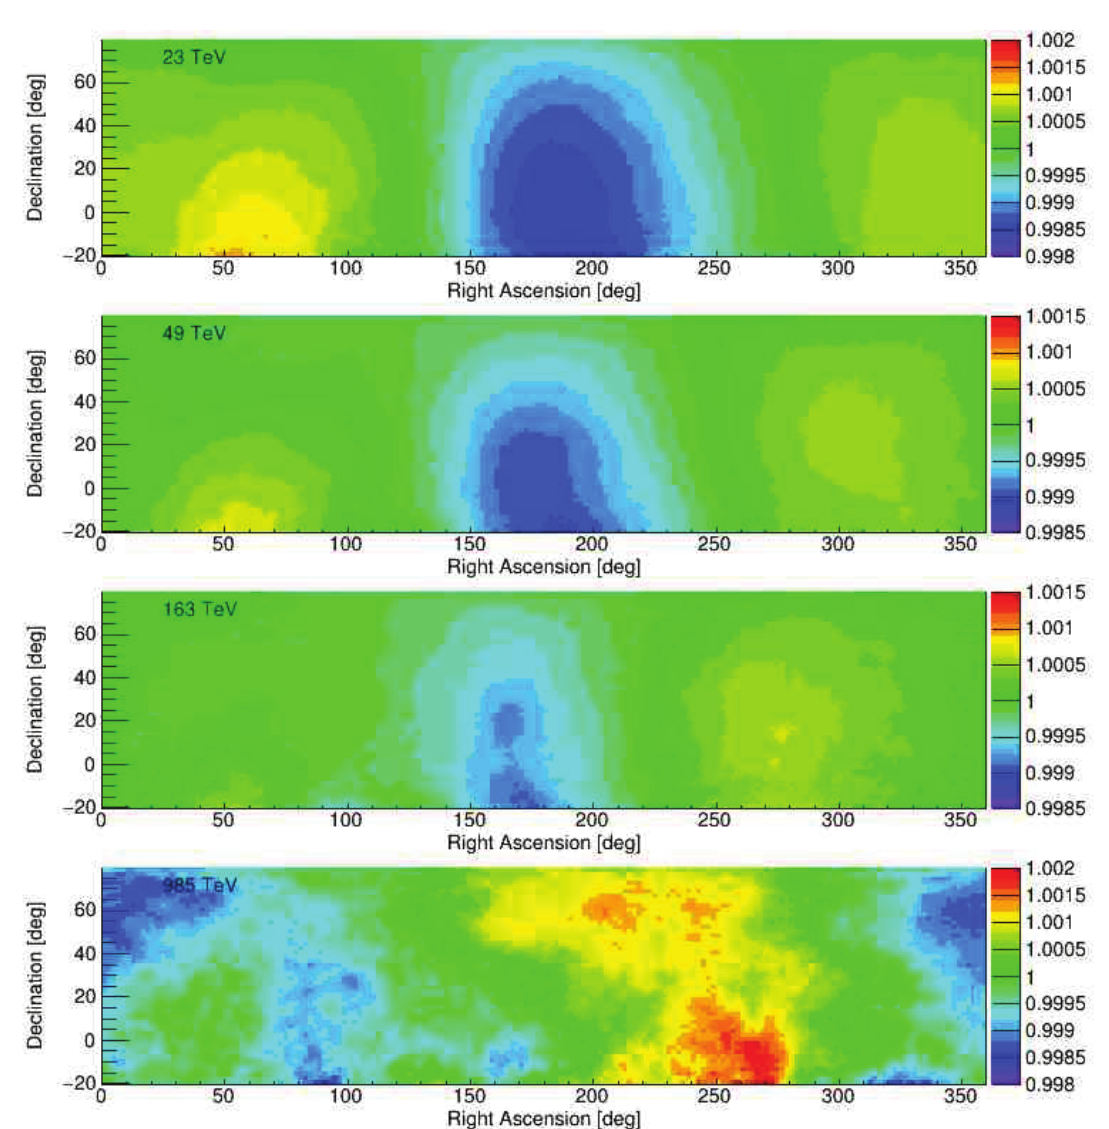
Figure 7. Anisotropy of flux of CRs at energies from 23 TeV to 1 PeV measured by